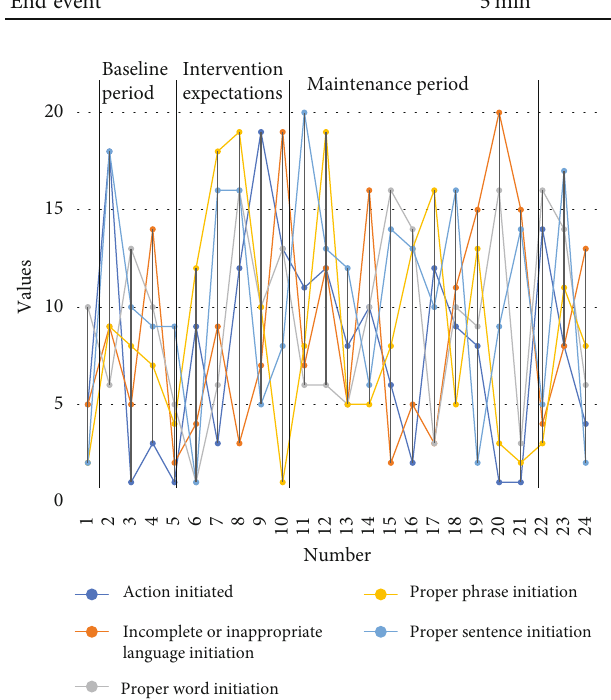
Figure 4: Frequency of behaviors with di ff erent levels of self-